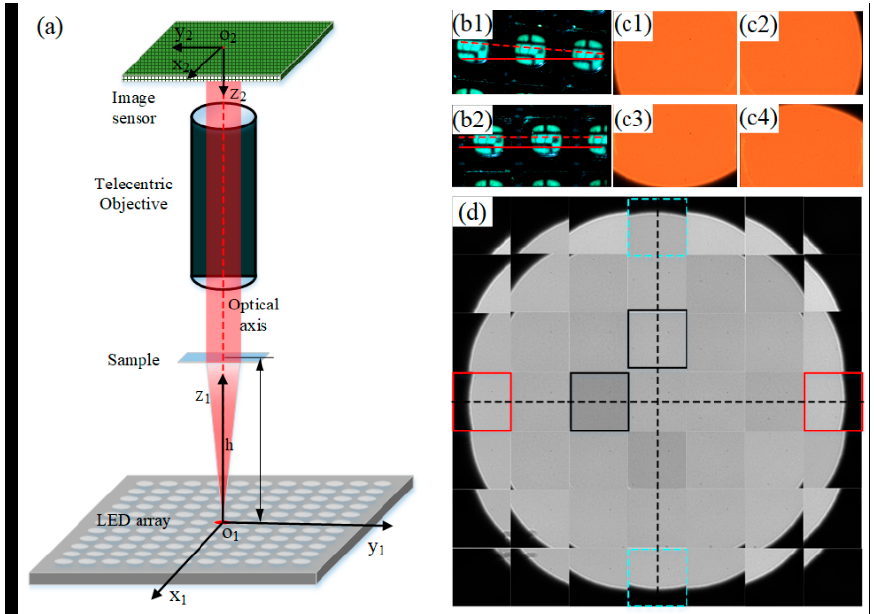
Figure 3. Alignment of proposed FPM platform. ( a ) The coordinate systems based on complementary metal–oxide–semiconductor (CMOS) plane and light-emitting diode (LED) array plane. ( b1,b2 ) The criterion for roll angle adjustment of the LED array. ( c1 – c4 ) The image criterion for adjustment of central LED position. ( d ) A mosaic image combining raw images of aperture diaphragm containing bright-field components.